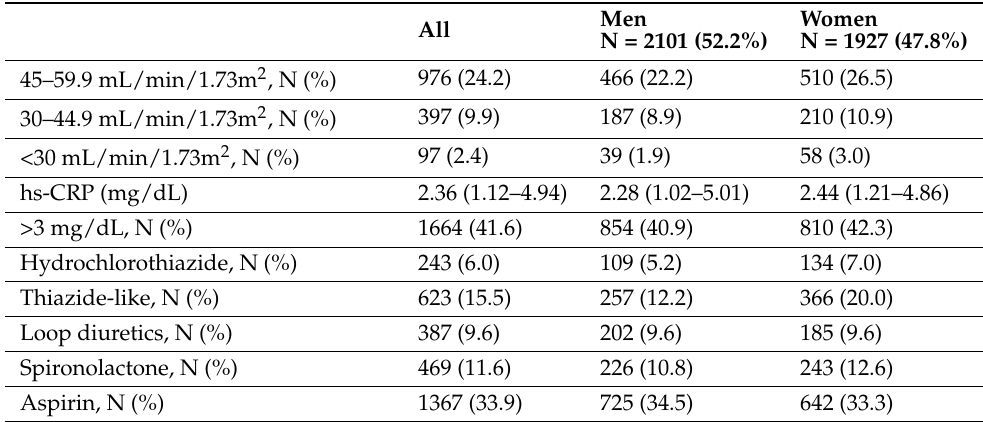
mean ± standard deviation or median (lower–upper quartile). Mean SUA level was 5.5 ± 1.6 mg/dL, regardless of inclusion/exclusion of subjects based on allopurinol usage. Higher levels were observed in men than in women (5.8 ± 1.6 vs. 5.2 ± 1.5; p < 0.001). There was a weak positive linear correlation between age and SUA level (r = 0.118; p < 0.001), more pronounced in women. For each decade of life, the mean SUA level rose by 0.2 mg/dL (Figure 2).